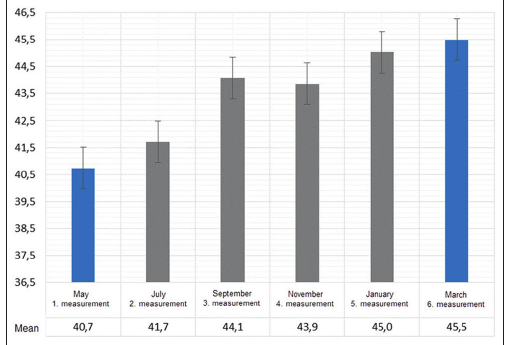
FIGURE 1. The quality of life of elderly people measured by Wilcoxon signed-rank test (1 st measurement versus 6 th measurement).